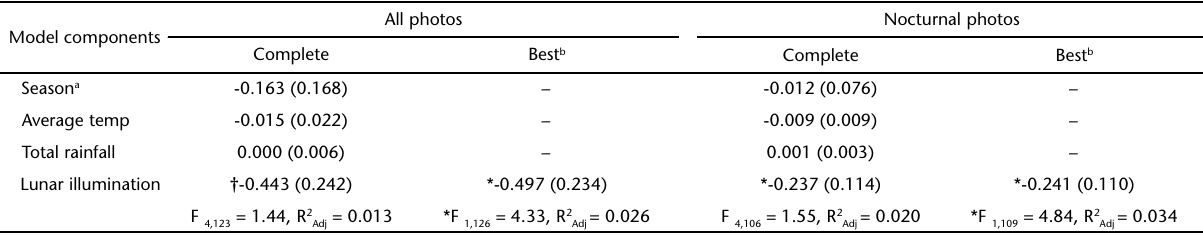
Table I. Slope coefficients (± SE) from linear models with predictors of the timing of Cuniculus paca activity (24 h – “All photos”, nocturnal – “Nocturnal photos”) monitored with camera traps in 24 forest sites surrounding the town of Alta Floresta. Model components